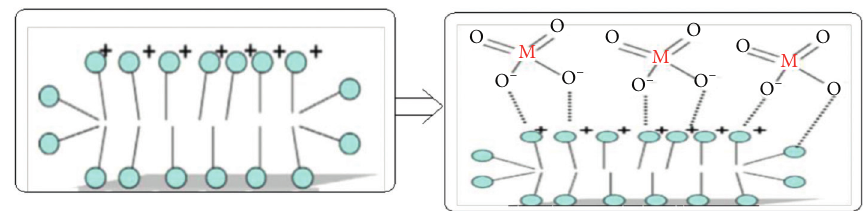
Figure 14: Adsorption of a metal oxyanion on a SMZ adopted from [61].